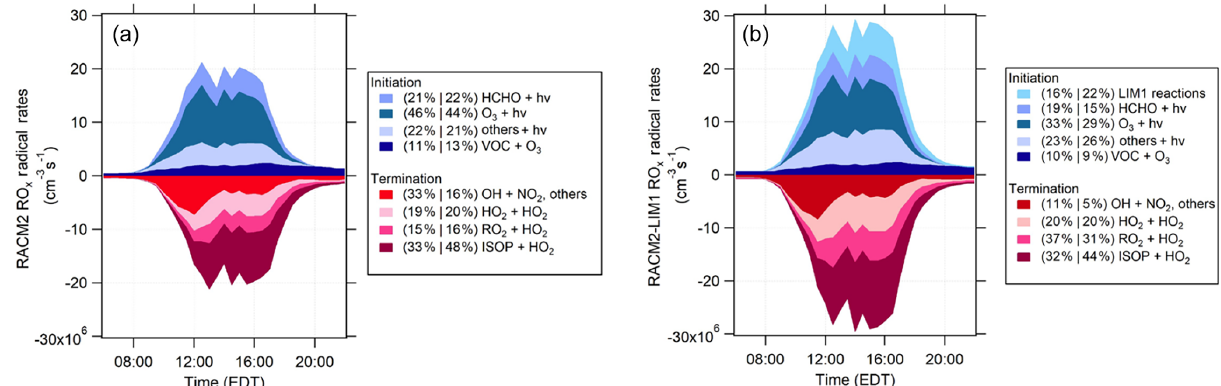
Figure 11. RACM2 (a) and RACM2-LIM1 (b) total RO x radical budgets for the days with NO measurements. Shades of blue represent initiation rates and the shades of red represent termination rates. The percent contribution of each reaction to total initiation/termination are divided into two periods (10:00 to 14:00EDT and 14:00 to 18:00EDT). The “Others + hν ” category includes the photolysis of HONO, H 2 O 2 , aldehydes, organic peroxides, and HNO 3 (see